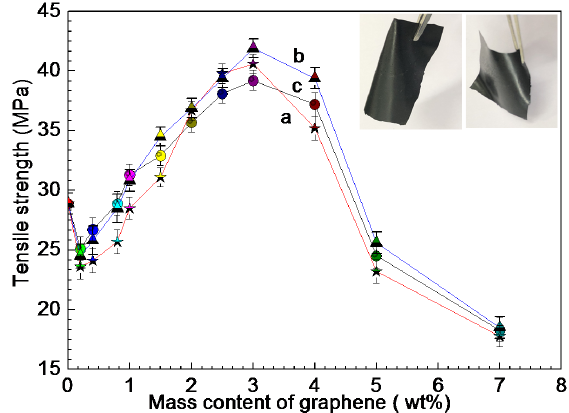
Figure 7. Tensile strength of RGO/NCC-TPU composite films with different mass contents of RGO/NC and TPU initial concentrations of 10 wt% (curve a), 20 wt% (curve b), and 30 wt% (curve c), respectively. The insets in Figure 7a are samples.